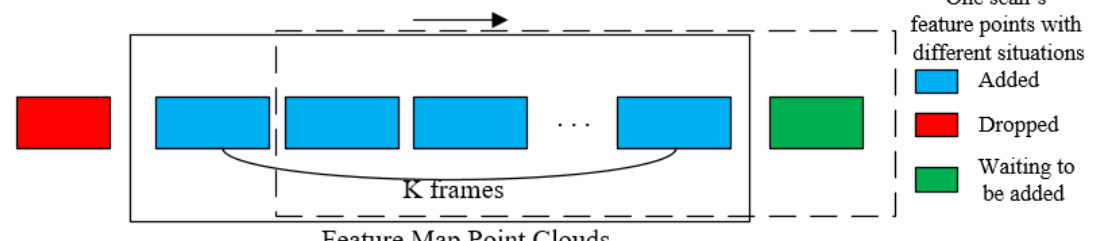
Figure 3. Workflow of the proposed method